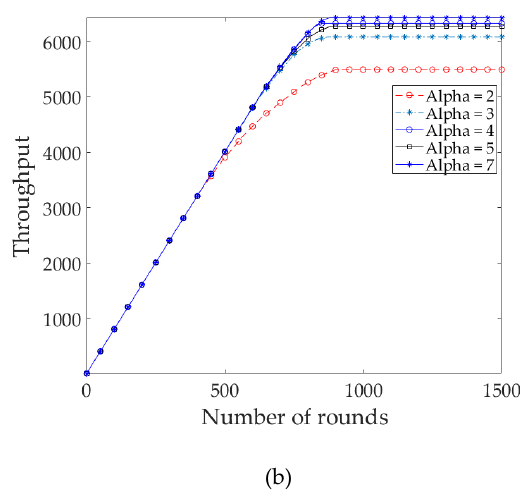
Figure 10. ( a ) Number of data packets sent to the sink for different T E in EDR (uniform); ( b ) Number of data packets sent to the sink for different T E in EDR (nonuniform).